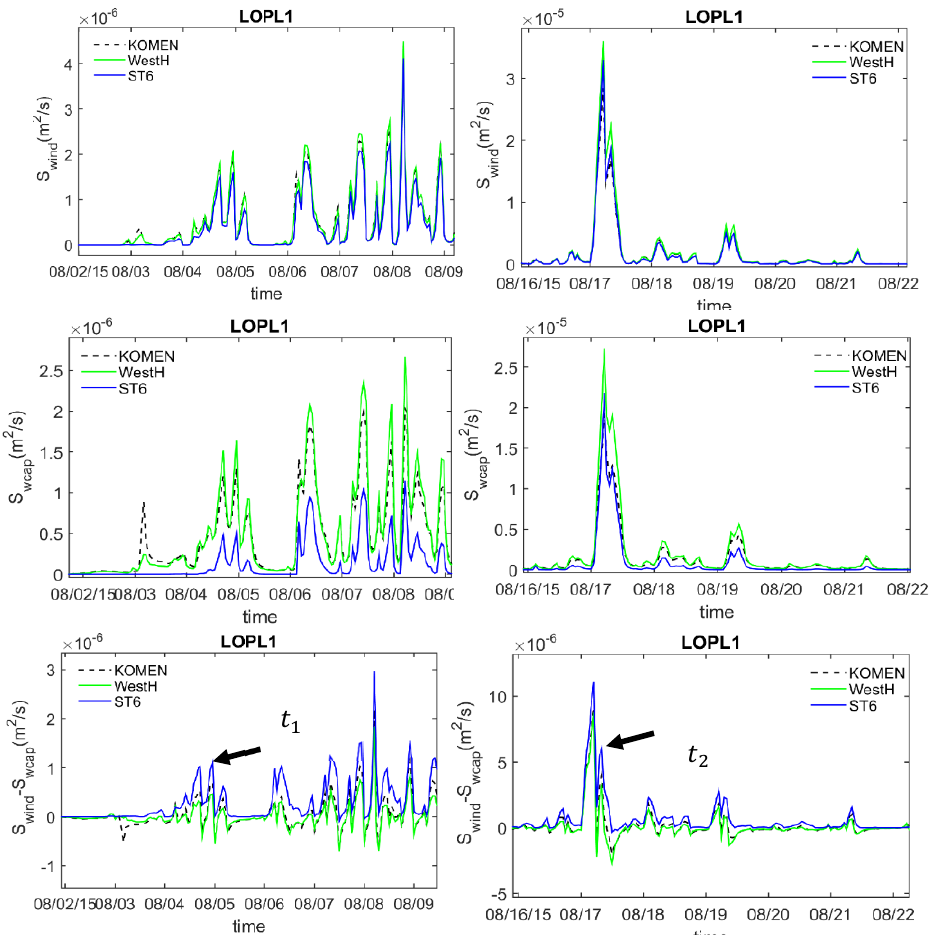
Figure 13. Timeseries of source term variations at LOPL1 for the two-time slots focusing on (left panels) time t 1 and (right panel) time t 2 . Upper panels: wind input, middle panels: whitecapping dissipation, lower panel: wind input-whitecapping dissipation. The arrows in the two lower panels are corresponding to the peaks of wave height shown in Figure 6A,B as times t 1 and t 2 .